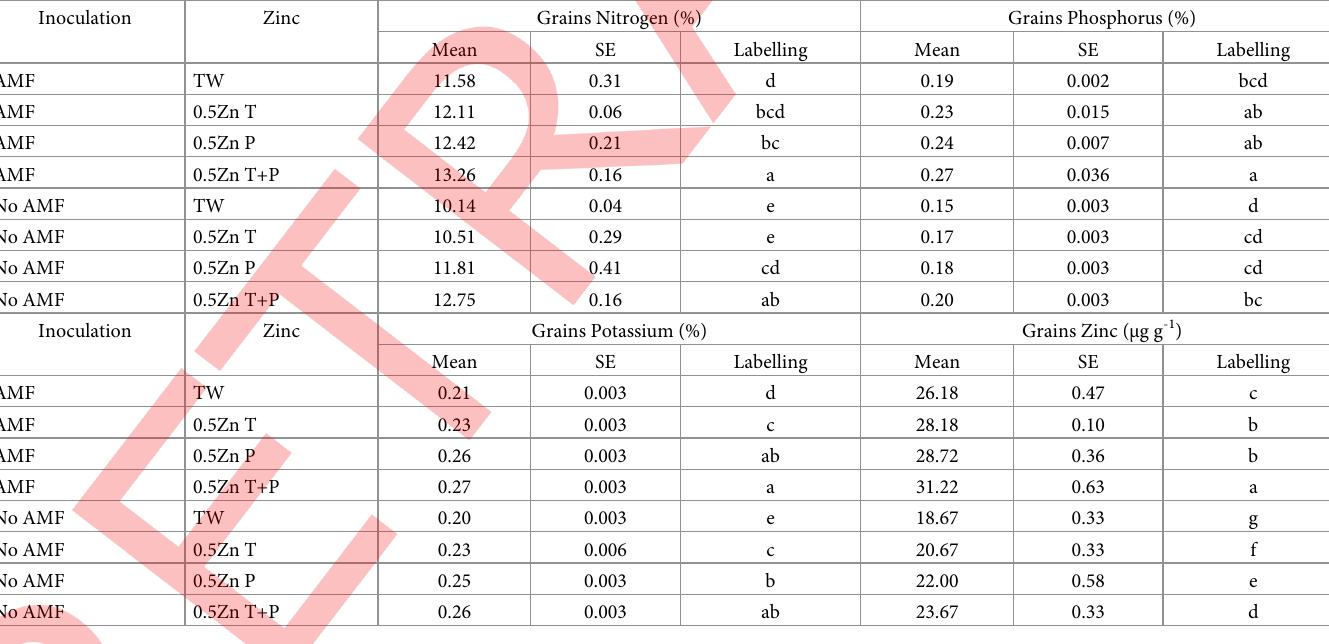
Values are means of 3 replicas ± SE. Variable letters showed significant difference at p � 0.05 compared by using Fisher LSD test. TW = tap water (control); T = tillering stage; P = panicle stage; Zn =